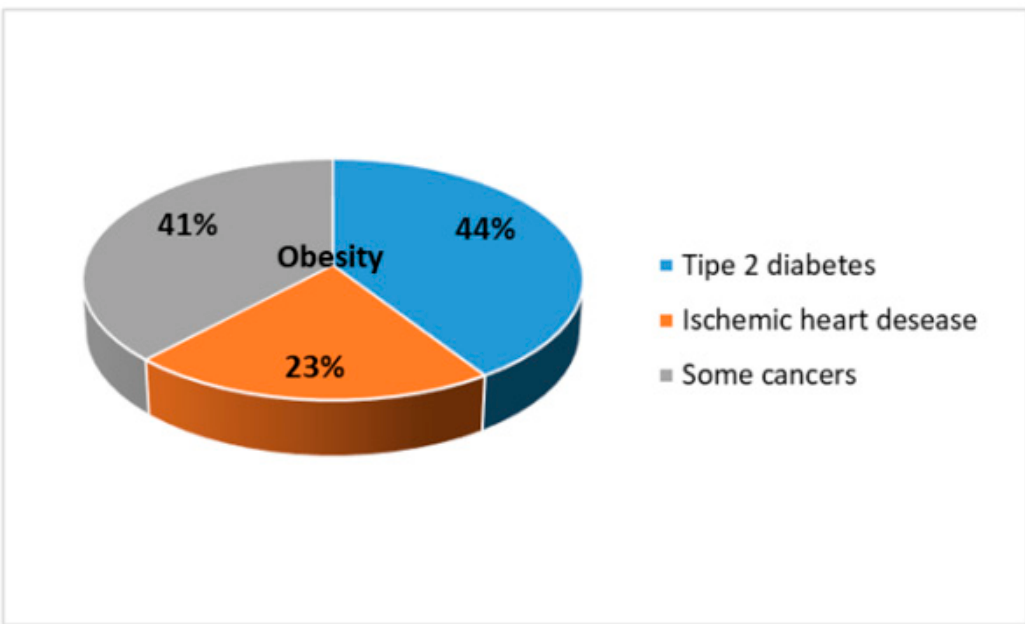
Figure 1. The main pathologies deriving from obesity.